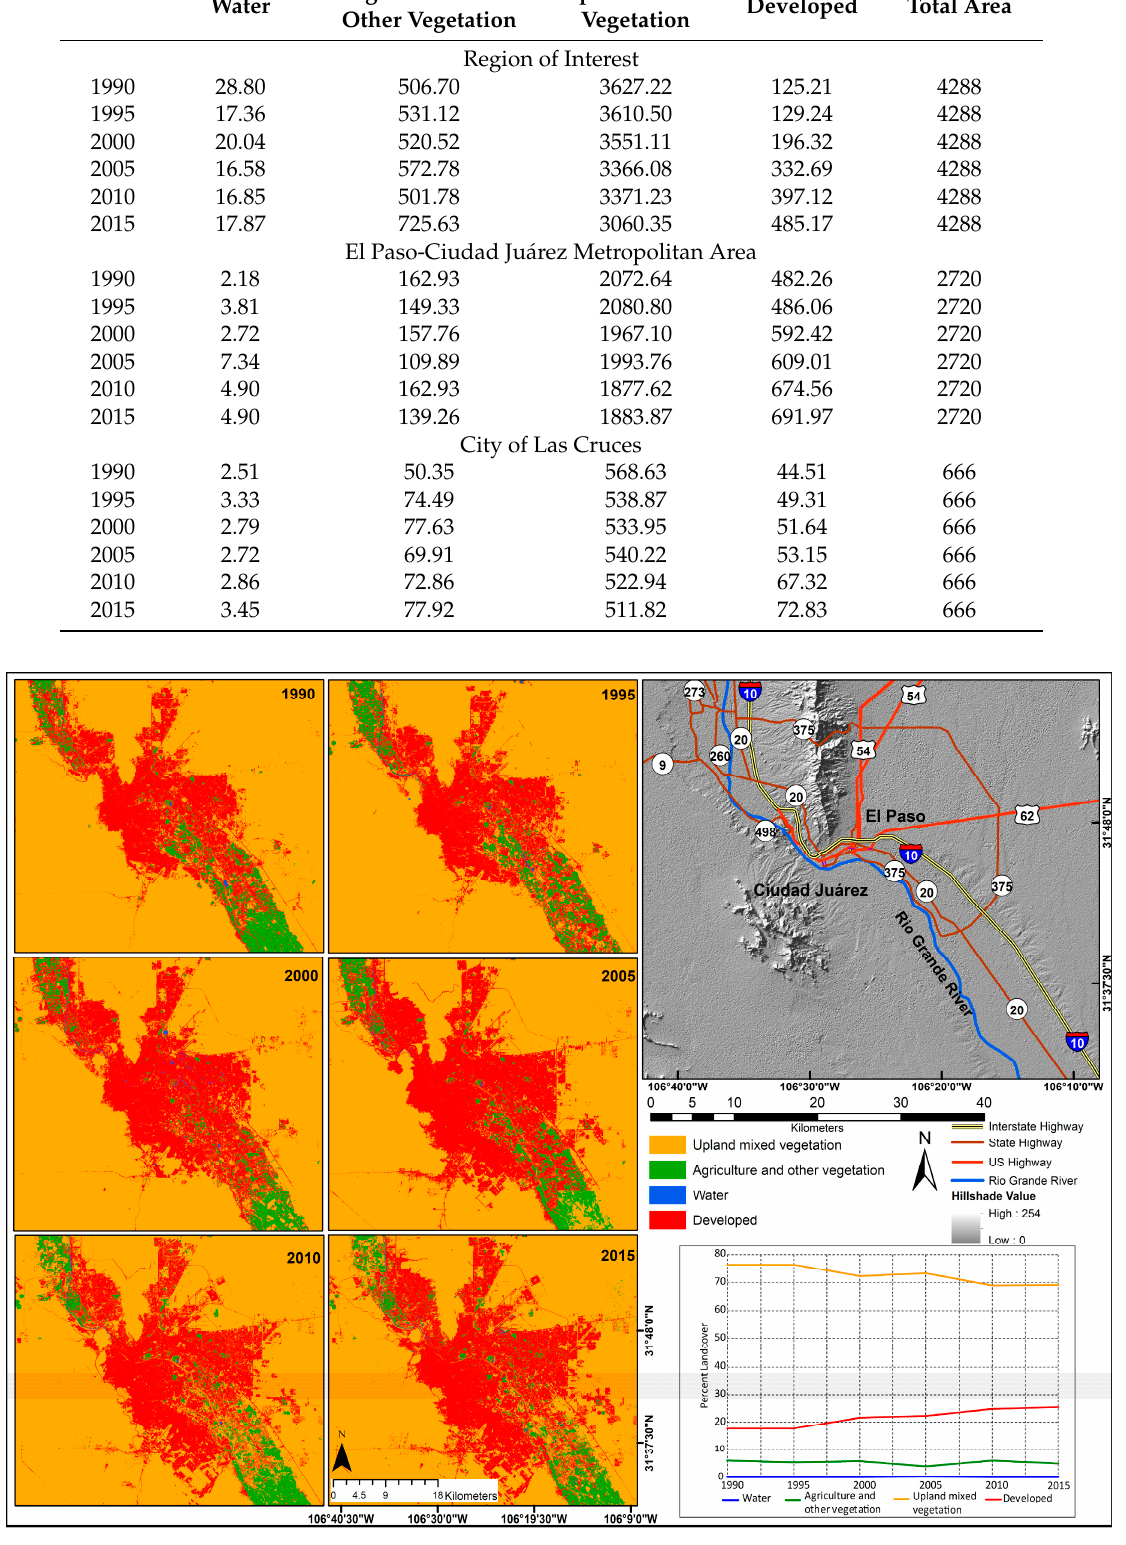
Figure 5. Land use change around the El Paso-Ciudad Juárez metropolitan area, 1990–2015.